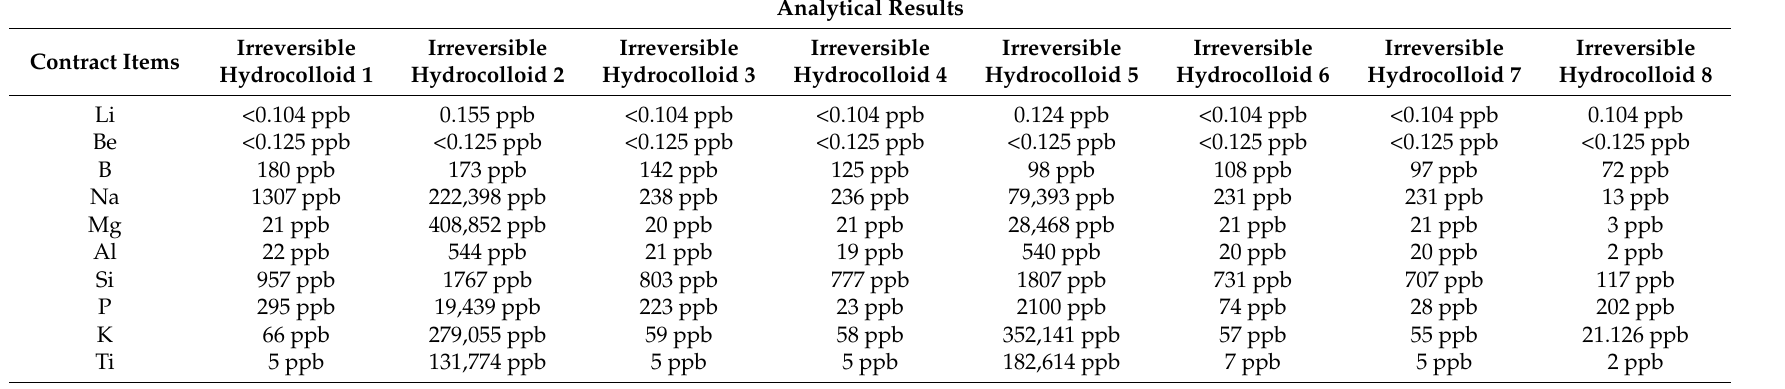
Table 1. Analytical results of the amount of Li, Be, B, Na, Mg, Al, Si, P, K and Ti in irreversible hydrocolloid.